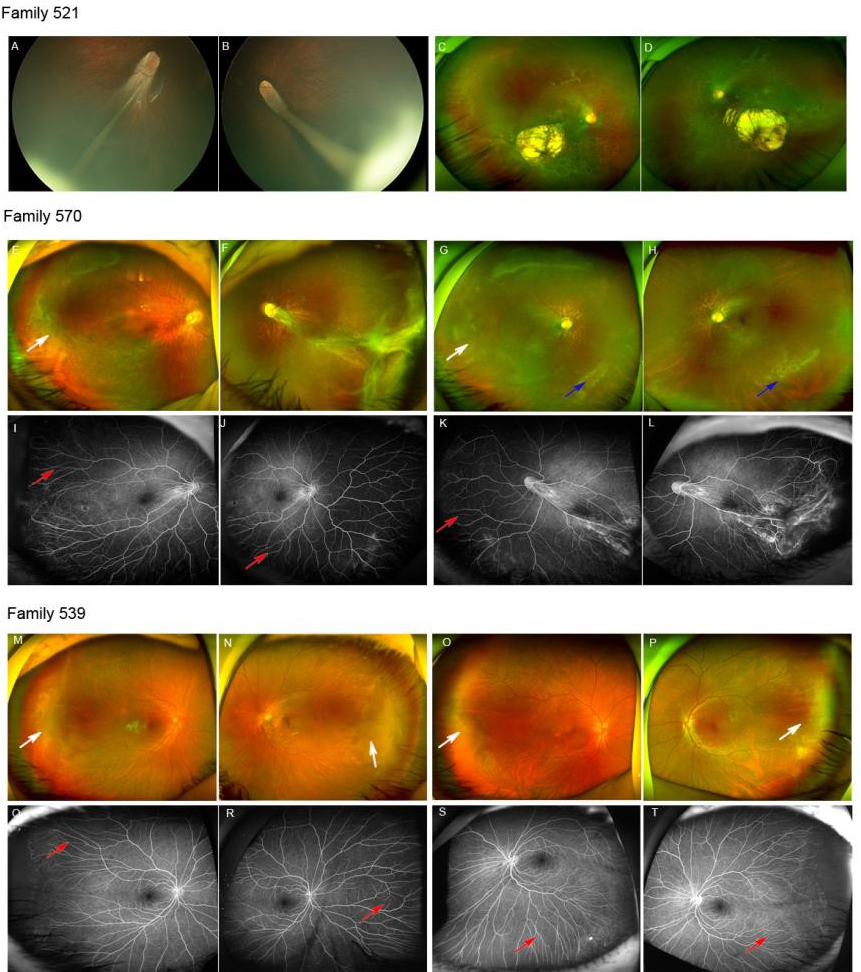
Figure 2. The c.2309_2310del was detected in a 5-month-old girl. The Retcam showed bilateral retinal folds in both eyes ( A , B ), while the SLO of her father showed symmetric chorioretinal dysplasia and exposed sclera located in the inferior and temporal retina ( C , D ). The c.139C>T was identified in a 5-year-old boy. The SLO demonstrated temporal mid-peripheral vitreoretinal interface abnormality (TEMPVIA) in the right eye (white arrow) and retinal folds in the left eye ( E , F ). The SLO of his mother showed TEMPVIA (white arrow) and lattice degeneration (blue arrow) in the peripheral retina ( G , H ). The FFA of the proband showed ISPVs in the temporal retina, nasal retina and inferior retina ( I – L ). The c.3073A>G was identified in a 5-year-old boy and his father. The SLO showed bilateral TEMPVIA (white arrow) in the temporal retina ( M , N ). His father’s SLO similarly showed mild changes ( O , P ). The FFA of the proband revealed ISPVs (red arrow) in the temporal retina, nasal retina and inferior retina ( Q – T ).